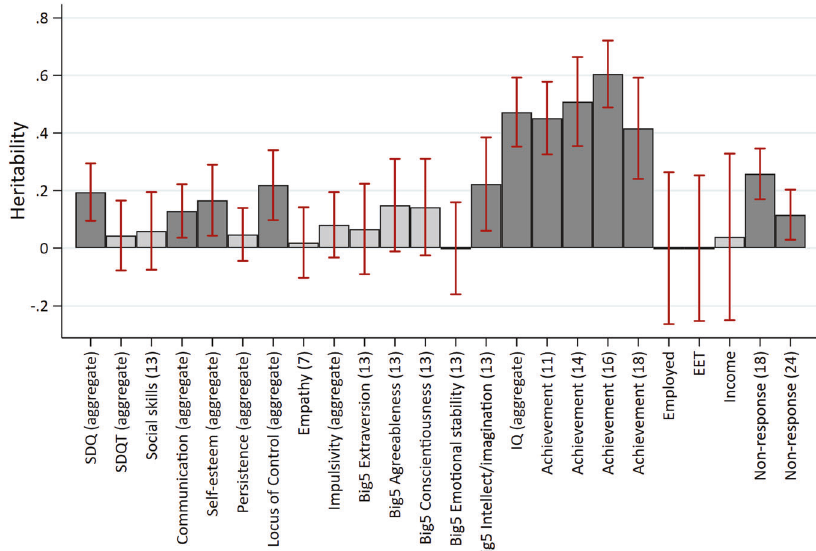
Fig. 6 Heritability of aggregate skills and outcomes. Dark shaded bars represent estimates below FDR threshold. Heritability estimated using GCTA-GREML on the full sample available for each phenotype. SDQ: parent reported strengths and dif fi culties questionnaire; SDQT: teacher reported strengths and dif fi culties questionnaire. EET: in education, employed or training. See Supplementary Table 8 for full reporting, or parental genetics in fl uencing offspring noncognitive noncognitive skills, which again may re fl ect greater measurement precision. The cognitive measures we used were more strongly correlated over the same period, though this may re fl ect that they were assessed using widely validated measures. Future studies that combine longitudinal data on noncognitive skills with multi- source multi-method approaches may be able to better elucidate relationships between noncognitive skills.